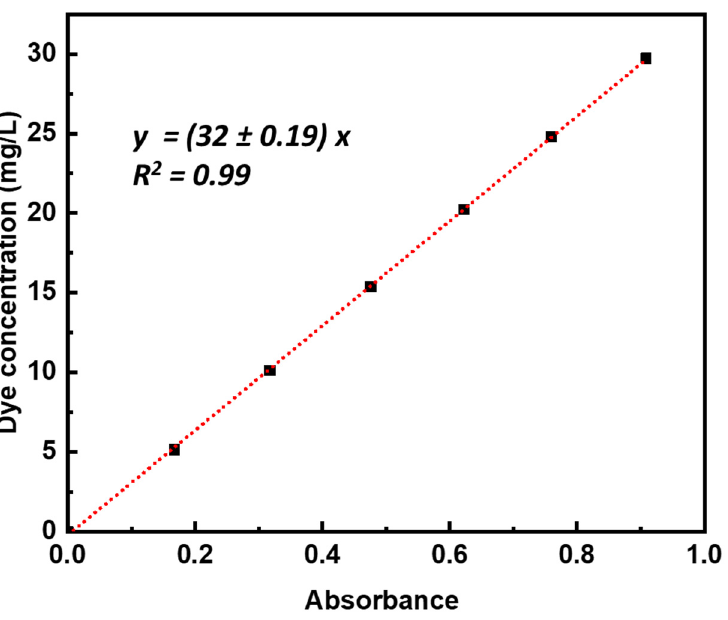
Figure 6. Concentration versus absorbance calibration curve for CR dye in water solution.